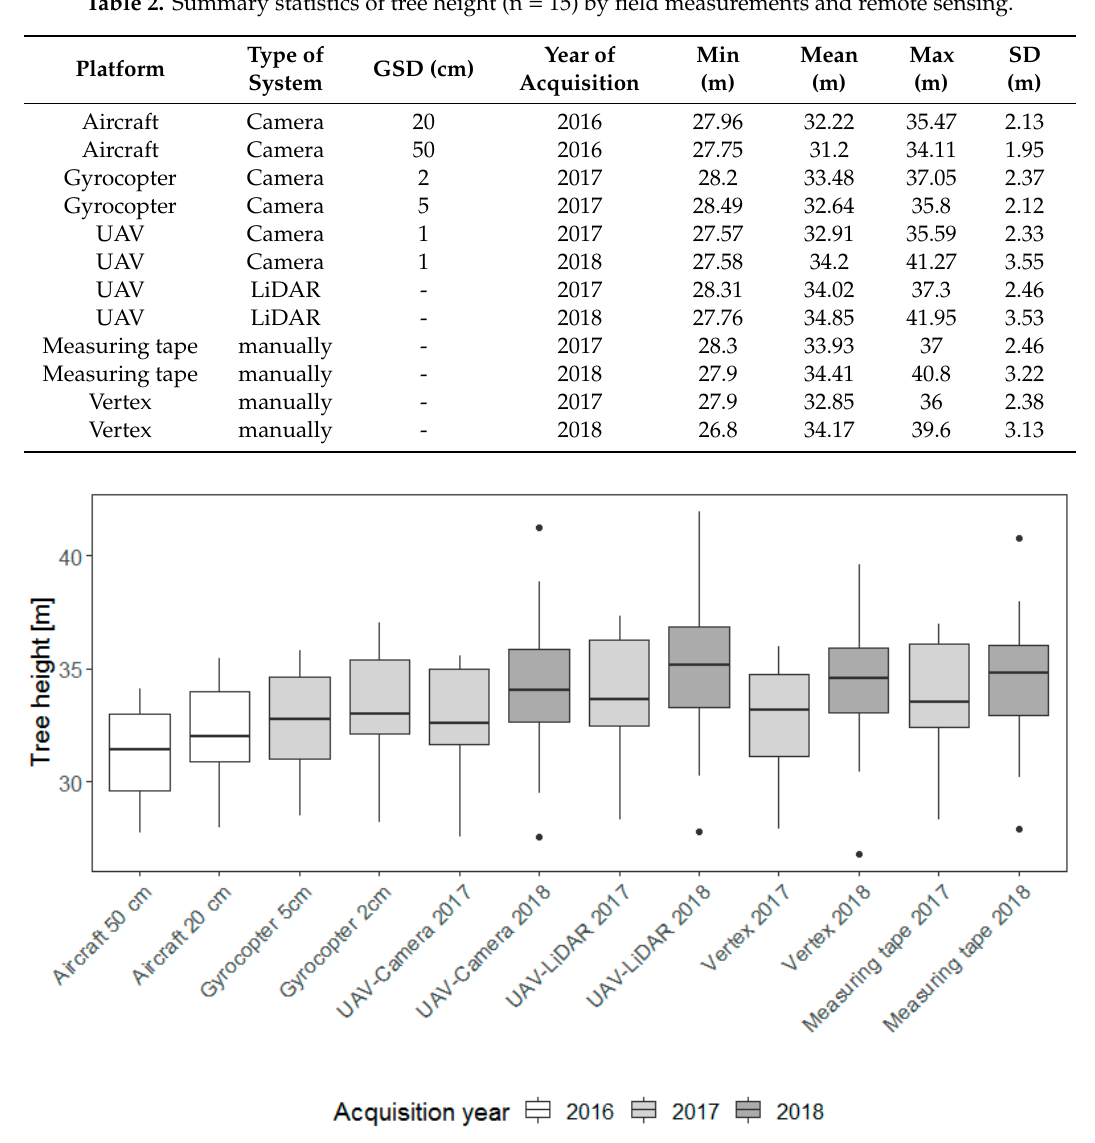
Figure 3. Boxplot analysis of tree heights ( n = 15) derived from field measurements and remote sensing.